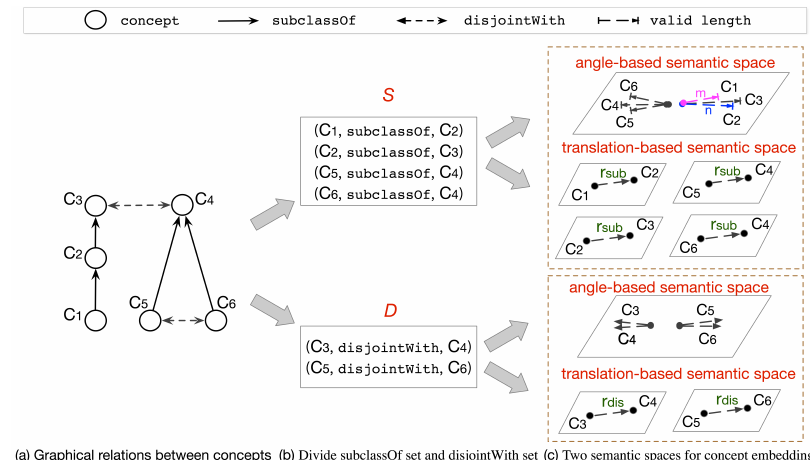
Figure 2. The framework of CosE for schematic knowledge